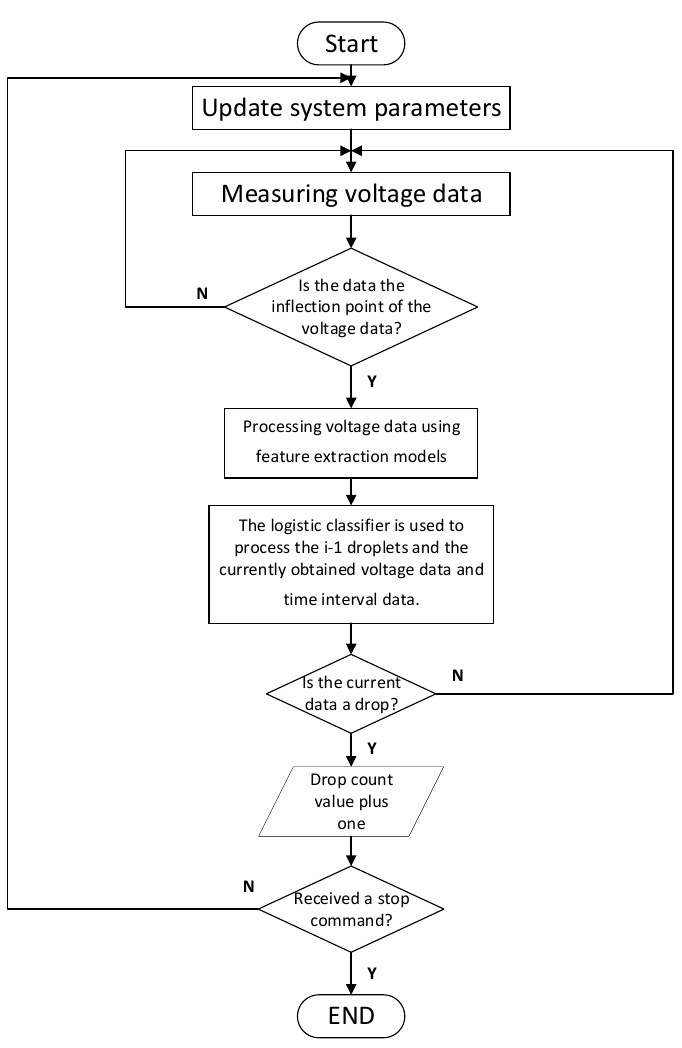
Figure 6. Droplet detection algorithm flow chart.